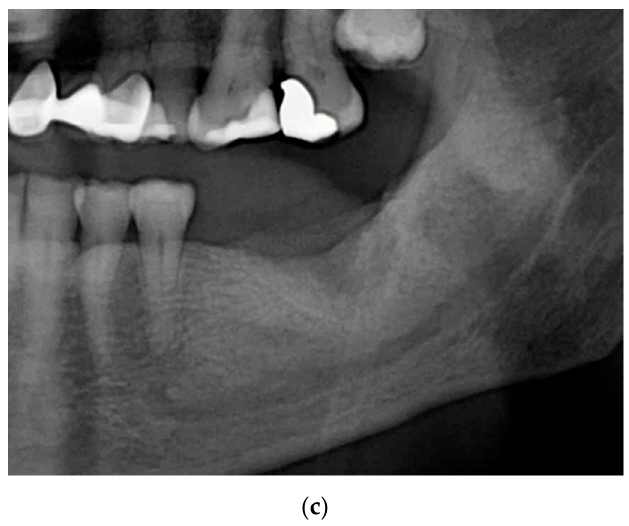
Figure 6. ( a ) Affected area 15 days post-surgery, ( b ) 30 days post-surgery and ( c ) X-ray 90 days post-surgery.